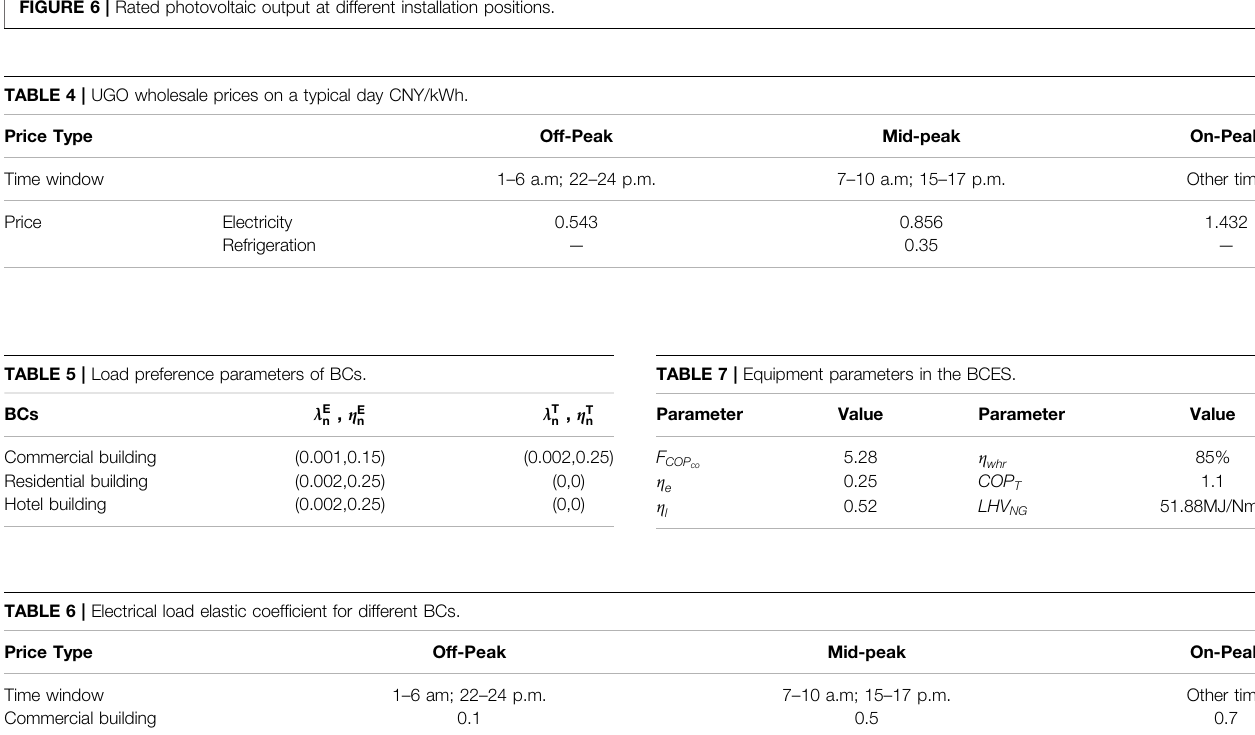
FIGURE 6 | Rated photovoltaic output at different installation positions.